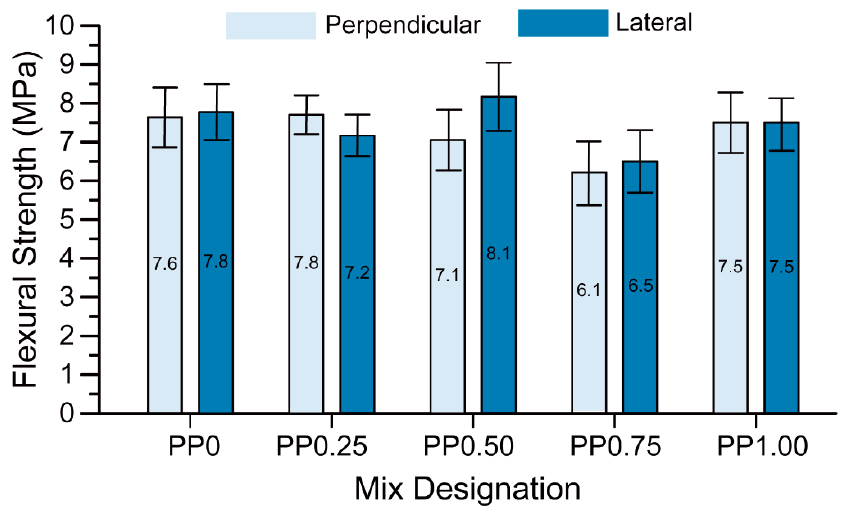
Figure 9. The flexural strength of printed specimens in two different directions.